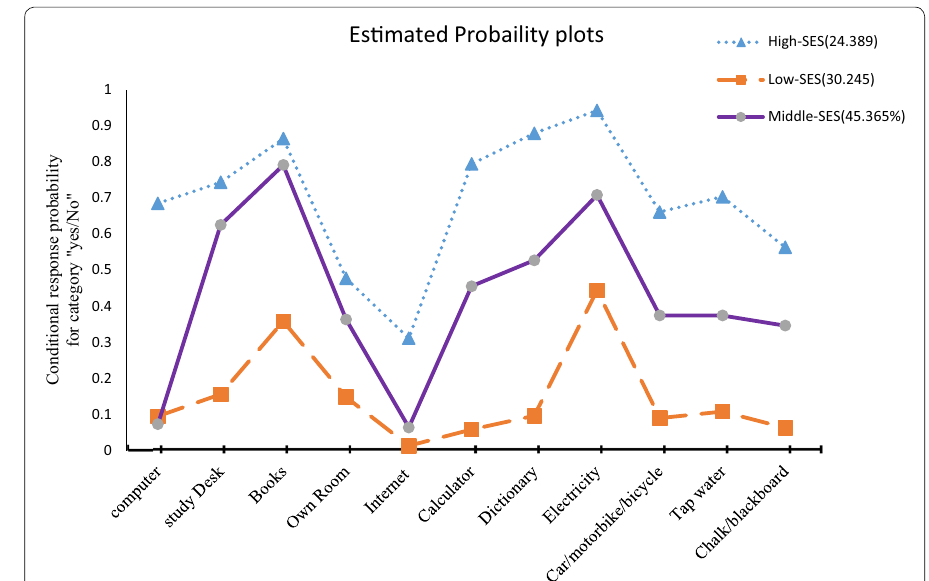
Fig. 1 Estimated probability plots indicating the socio‑economic profiles of the